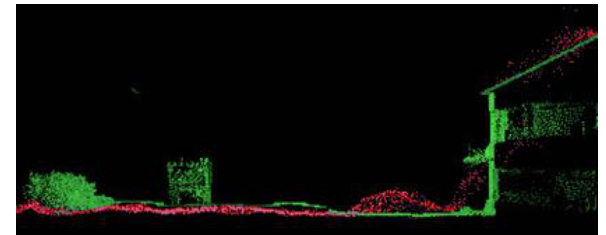
Figure 1. DSMs (Green: from MLS, Red: from UAV)